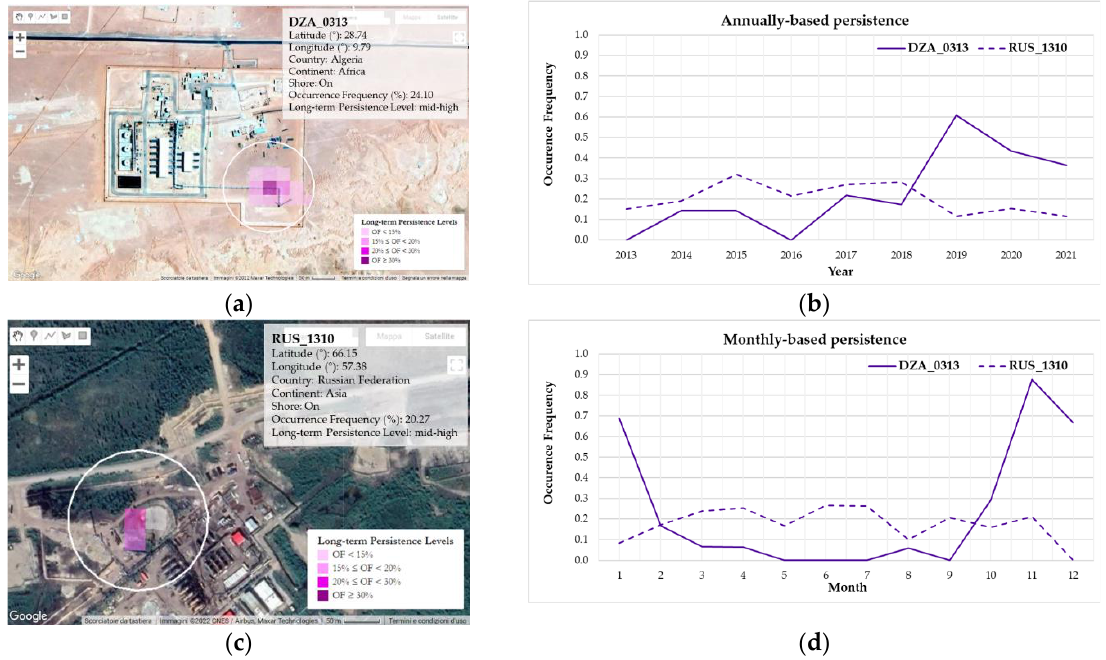
Figure 8. Features of the selected onshore GF sites, labeled as ( a ) DZA_0313 and ( c ) RUS_1310, retrieved from the DAFI GEE tool; the insets summarize the GF geographic information, along with its long-term persistence category. The ( b ) annual and ( d ) monthly temporal persistence for DZA_0313 (purple line) and RUS_1310 (purple dashed line).